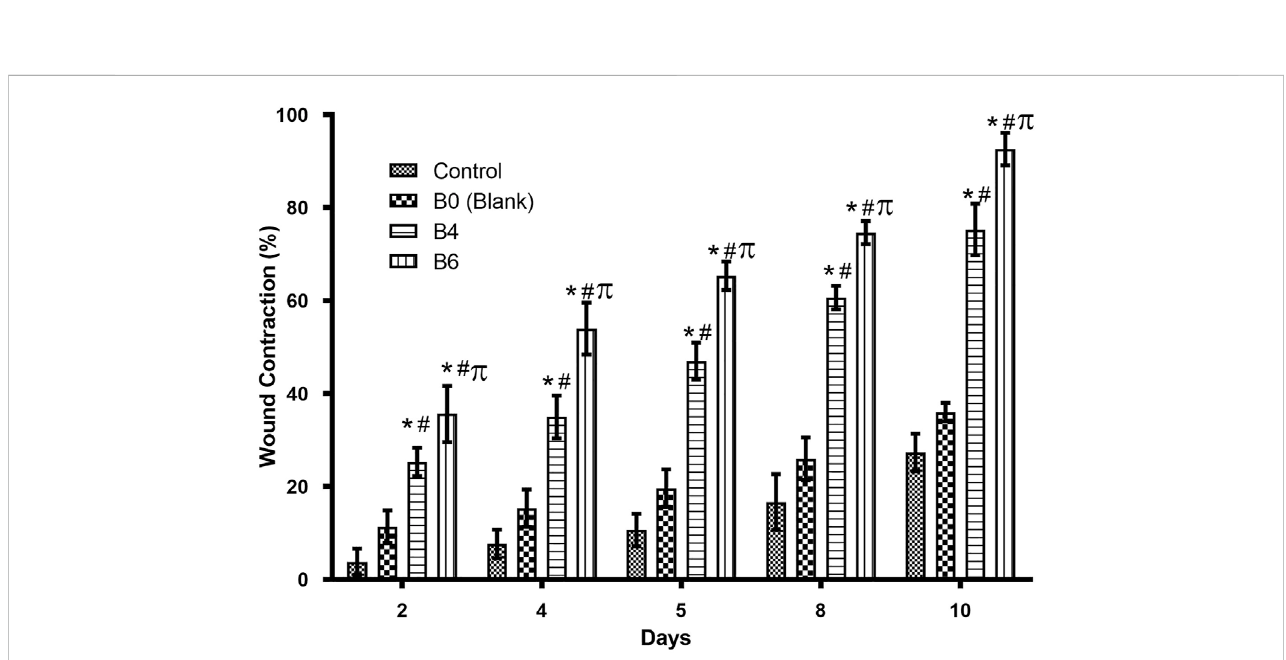
FIGURE 8 Comparison of wound healing activity of different formulations on different days. Error bar represents the standard deviation (n = 4; p -value ˂ 0.05, *compared with control, # compared with Blank, and π compared with